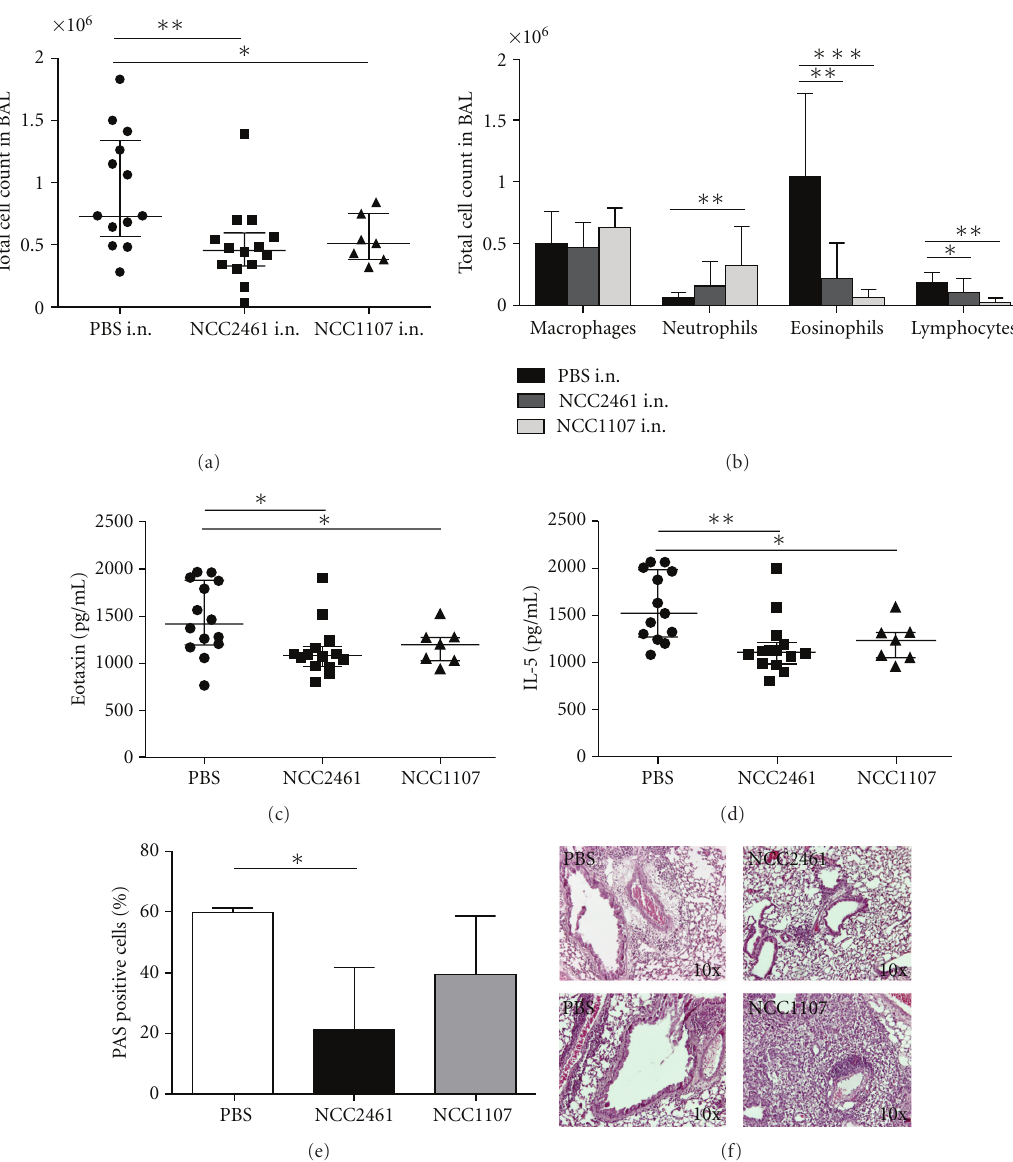
Figure 3: E ff ect of intranasal L. paracasei NCC2461 and L. plantarum NCC1107 on lung airway inflammation. L. paracasei NCC2461 (1 × 10 9 CFU), L. plantarum NCC1107 (1 × 10 9 CFU), or PBS were administered intranasally (i.n.) in OVA-challenged mice. Total (a) and di ff erential (b) cell counts were performed in the BALF. Eotaxin (c) and IL-5 levels (d) in lung homogenate were quantified by ELISA. Lung sections were PAS stained (results are expressed as % of PAS positive cells (e)) and H&E stained (f), reflecting the severity and localization of inflammation (magnification × 10). In this representative experiment, histograms are mean ± SD from 10 animals; ∗ P < 0 . 05, ∗∗ P < 0 . 005, ∗∗∗ P < 0 .